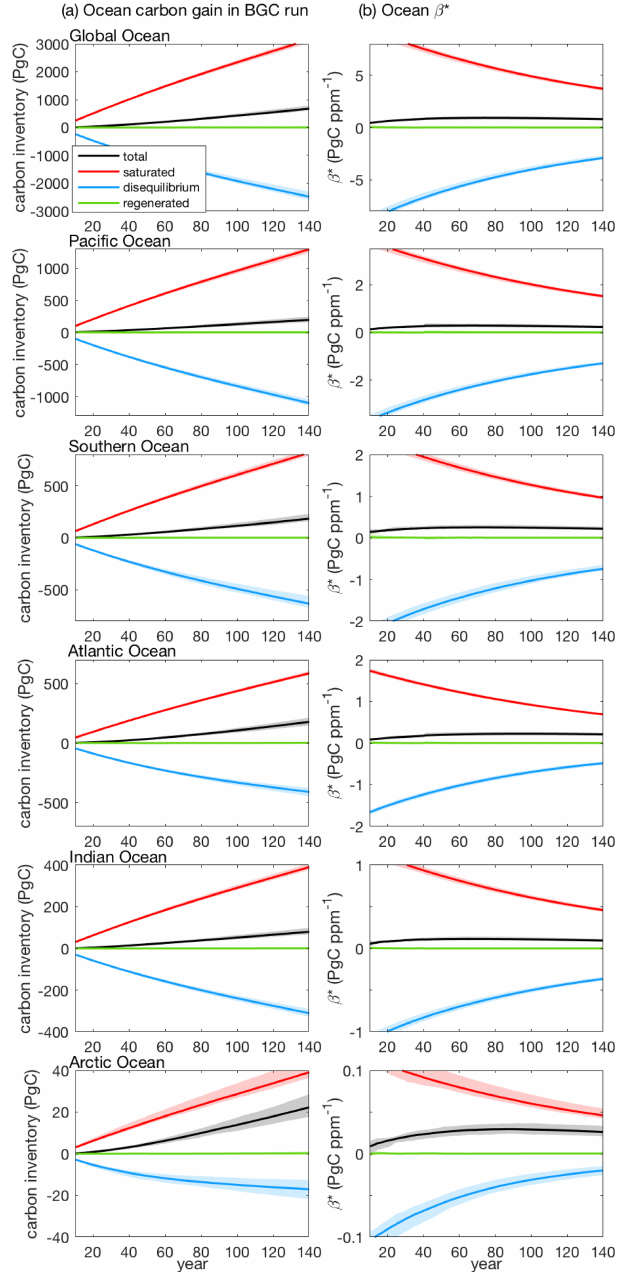
Figure 3. Ocean carbon storage and ocean carbon–concentration feedback parameter, β ∗ , for the global ocean and different ocean basins, along with the contribution from the saturated, disequilib- rium and regenerated carbon pools in CMIP6 Earth system models: (a) ocean carbon inventory changes relative to the pre-industrial era in the biogeochemically coupled simulation (BGC) and (b) ocean carbon–concentration feedback parameter based on carbon storage, β ∗ (PgCppm − 1 ). The solid lines and the shading show the model mean and the model range, respectively, based on the 1%yr − 1 in- creasing CO 2 experiment over 140 years in 11 CMIP6 models (Ta- ble 1). Note that for the global ocean, β ∗ is equivalent to β